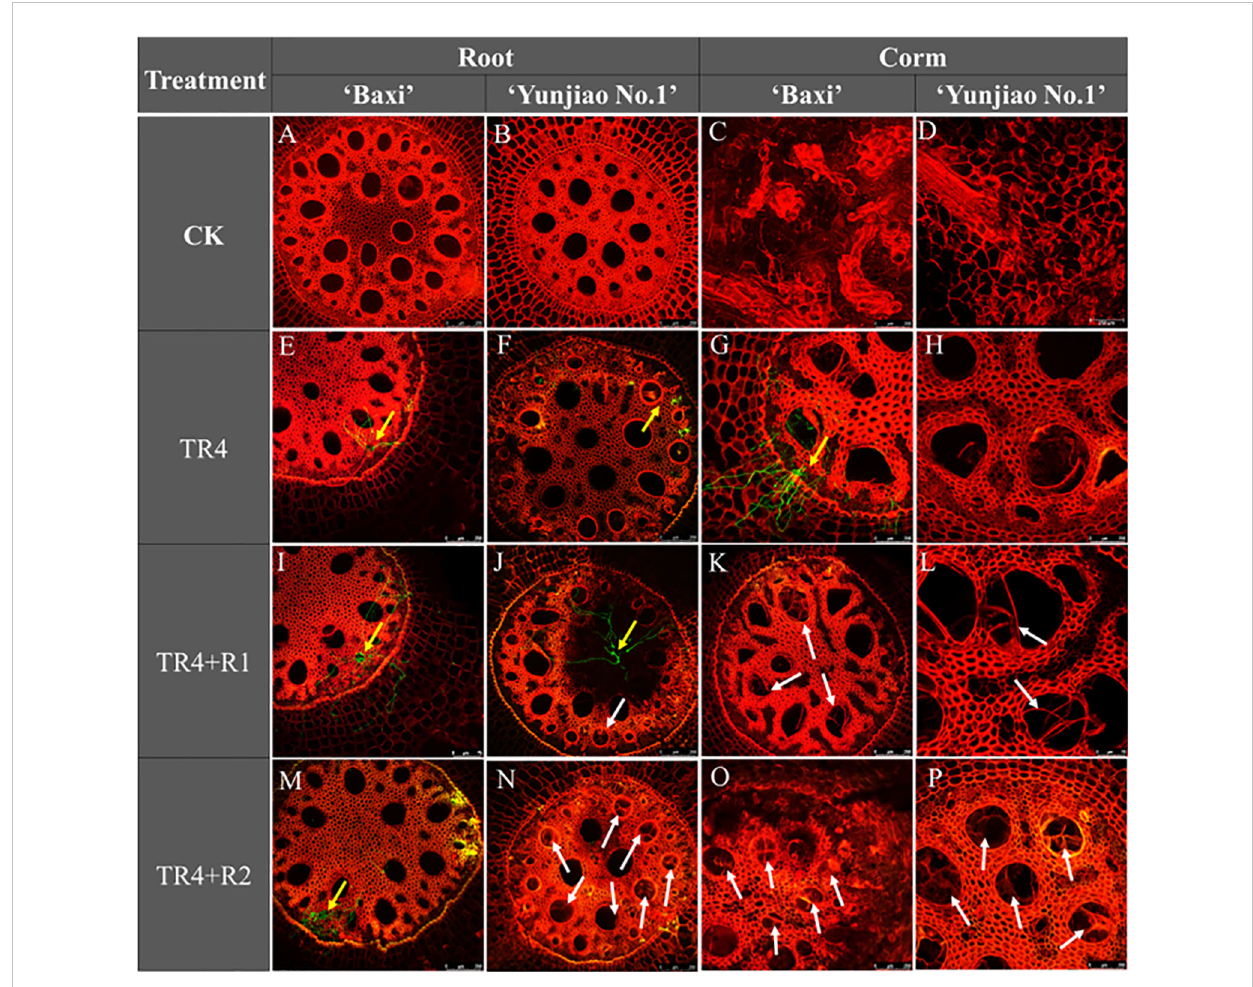
FIGURE 6 Microscopic observation of tyloses in banana corms and root at 62 days post inoculation TR4 (62 dpi) and mock inoculation. The tyloses was indicated by white arrows in the banana plant tissues. The TR4 hyphae was indicated by yellow arrows in the banana plant tissues. Photographs were taken under 488 (GFP) channel and 561 (RFP) channels (A – P) . Bar = 250 m m in (A – H, J, K, M – P) ; Bar = 75 m m in